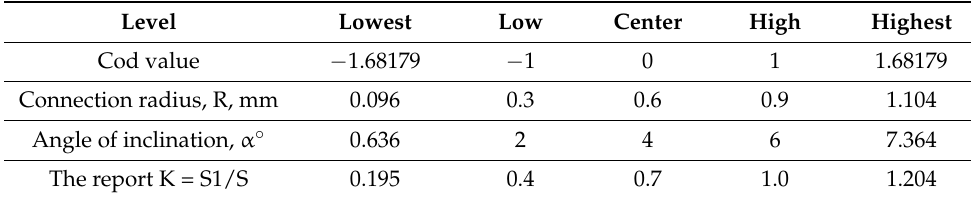
Table 2. Level parameters using the central composite design method.